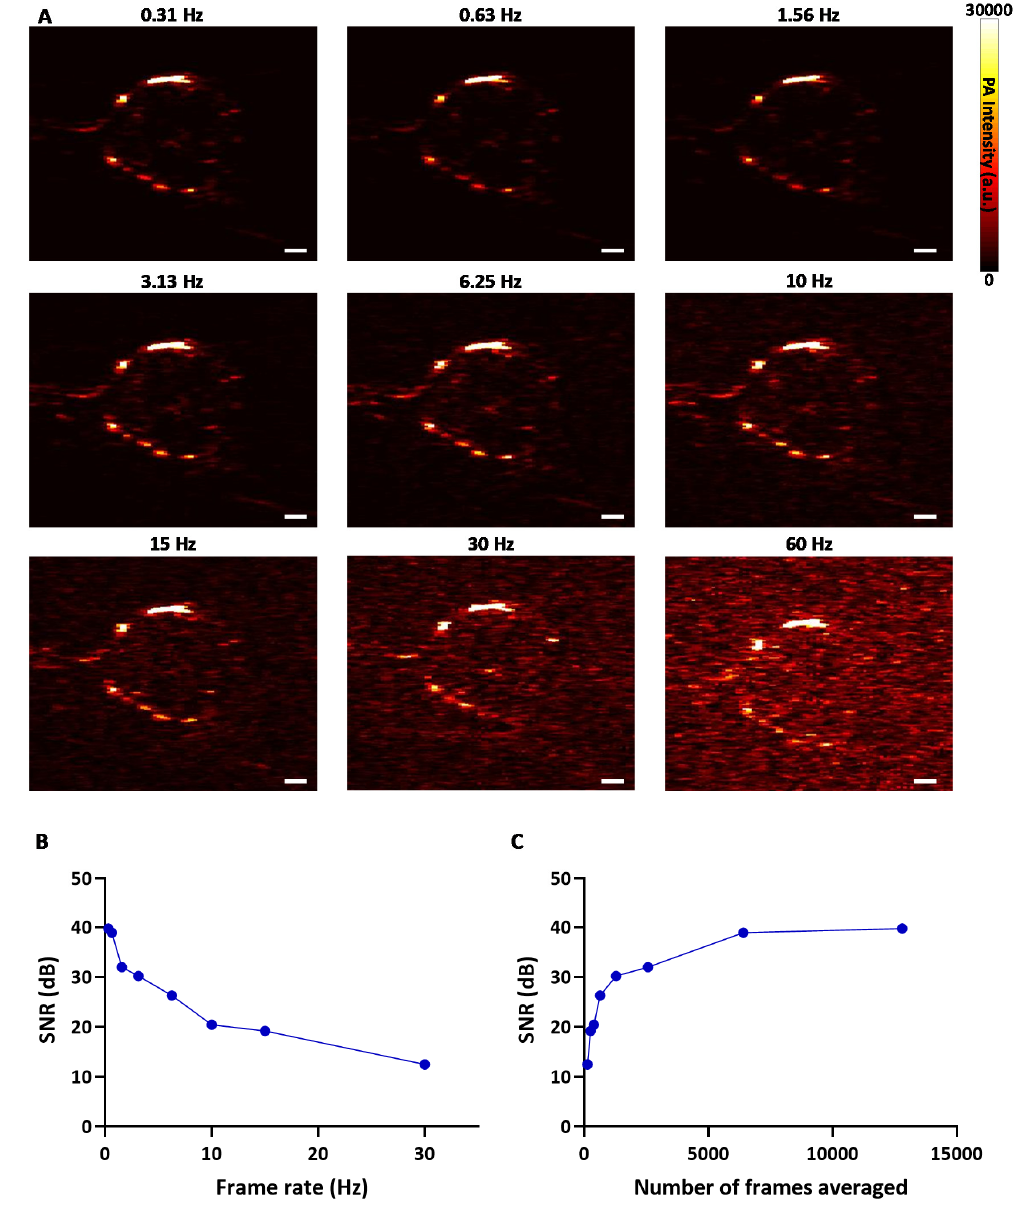
Figure 3. The signal ‐ to ‐ noise ratio (SNR) is enhanced by averaging several frames in the LED ‐ based PA imaging system. ( A ) PA images of a tumor acquired and processed at different frame rates. ( B ) Relationship between the frame rate and SNR. ( C ) Plot detailing the SNR change with respect to the averaging of frames. (Scale bar = 2 mm).